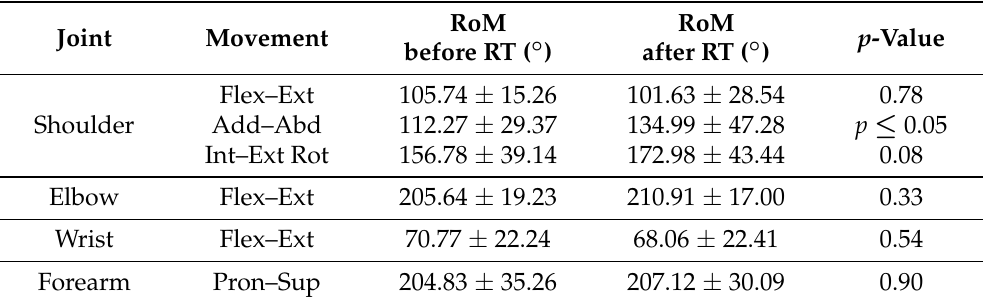
Table 11. RoM obtained for the paretic limb in the Apley Scratching Test before and after the rehabilitation therapy.